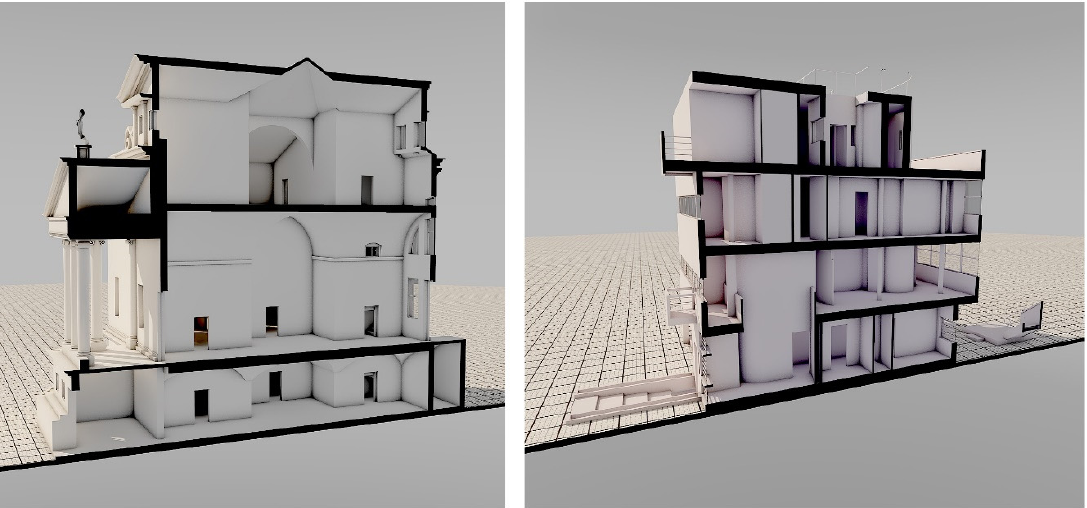
Figure 4. Cutaway cross section through Palladio’s Villa Malcontenta ( left ) and Le Corbusier’s Villa Stein ( right ).